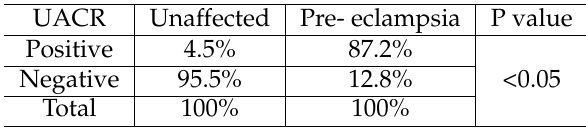
Table 2. Association of preeclampsia with